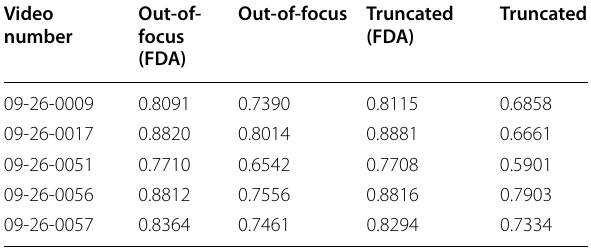
Table 4 Comparison of fault tolerance